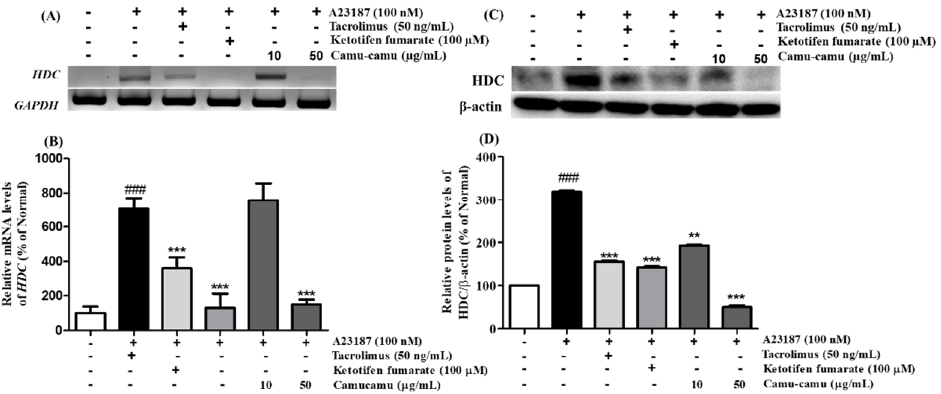
Figure 5. Effect of camu-camu fruit extract on mRNA ( A , B ) and protein expression ( C , D ) of HDC in A23187-induced RBL-2H3 cells. mRNA level was normalized to GAPDH , while protein level was normalized to β -actin. The results were calculated as the percentage of non-treated cells and displayed as mean ± SD of three independent experiments ( ### p < 0.001 vs. the control group, ** p < 0.01 and *** p < 0.001 vs. the A23187-treated